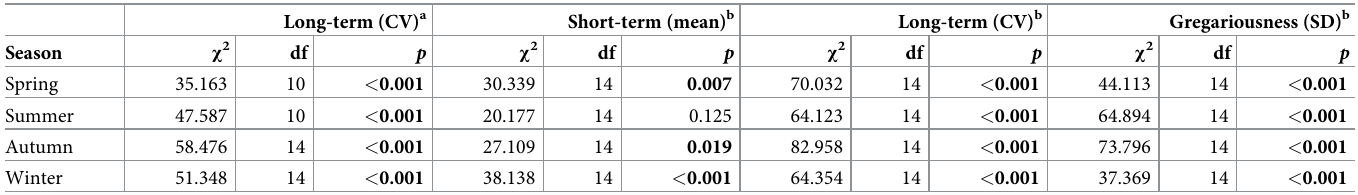
Table 1. P- values combined using Fisher’s omnibus test, from the Manly/Bejder test for preferred and avoided companions using two permutation methods a,b . Long-term (CV)